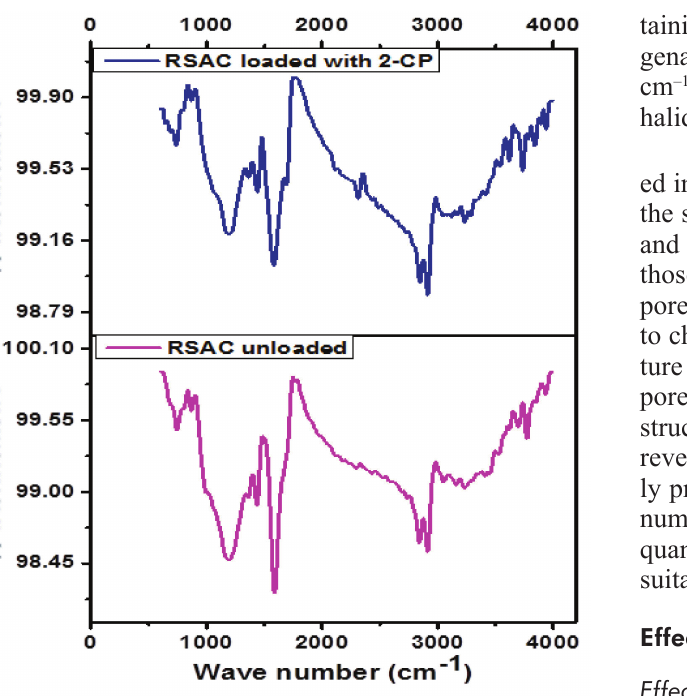
Fig. 3 – FTIR spectra of RSAC before and after adsorption of